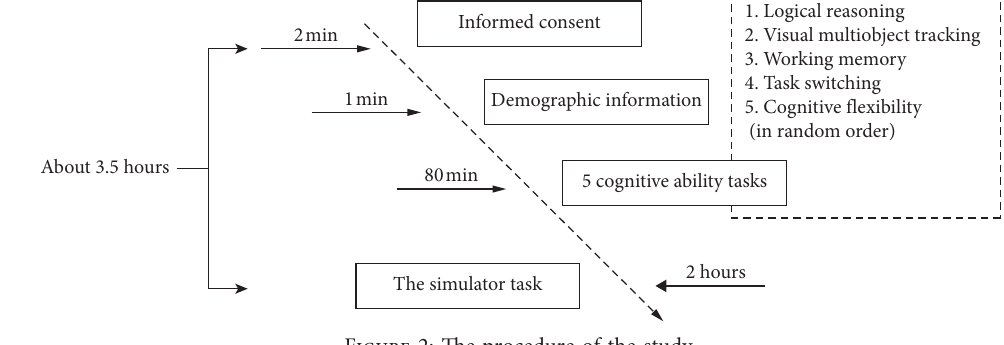
Figure 2: The procedure of the